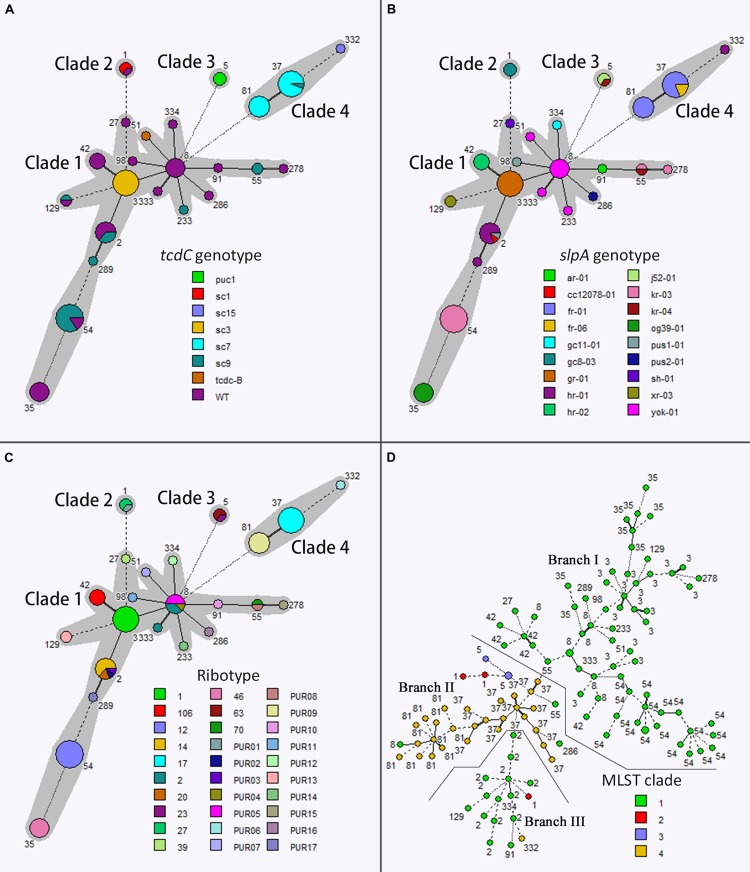
Minimum spanning tree analysis based on allelic profiles of multilocus sequence typing (MLST) (A,B,C) and Multilocus variable-number tandem-repeat analysis (MLVA) (D) data. Each circle in (A,B,C) corresponds to a MLST ST, and each circle in (D) corresponds to a MLVA genotype. Different circle colors represent tcdC genotype, slpA genotype, PCR ribotype, and MLST clade in (A,B,C,D), respectively. The gray halo surrounding the MLST STs in (A–C) denotes STs belonging to different MLST clades. The lines between circles indicate the similarity between profiles: bold line, six of seven MLST alleles/MLVA loci in common; normal line, five alleles/loci in common; dashed line, four alleles/loci in common; dotted line, ≤3 alleles/loci.